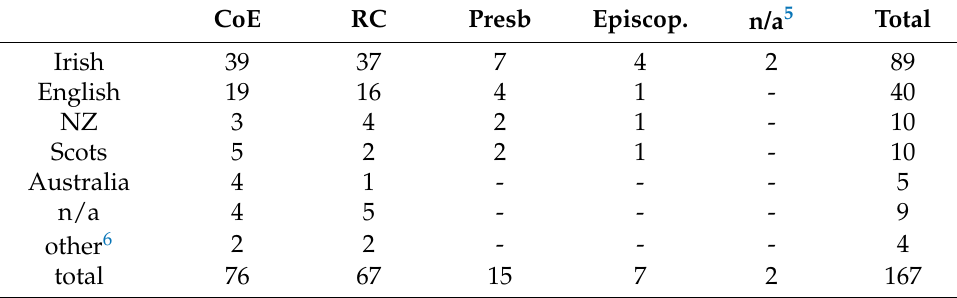
Table 1. Nationality and religion of Armed Constabulary recruits (1877) 4